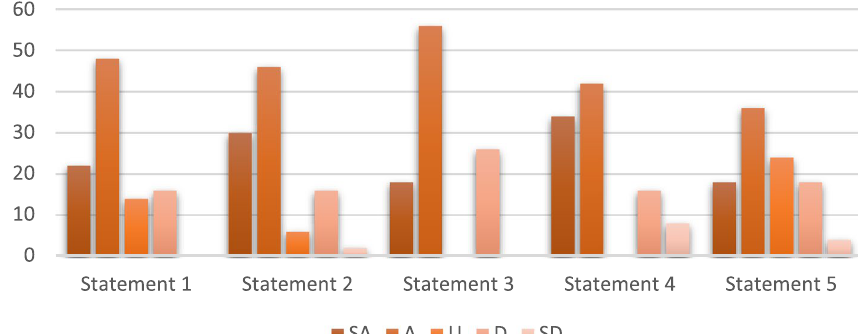
Fig. 12 Factors that influence the democratic distribution of languages in the radio stations in Hunan